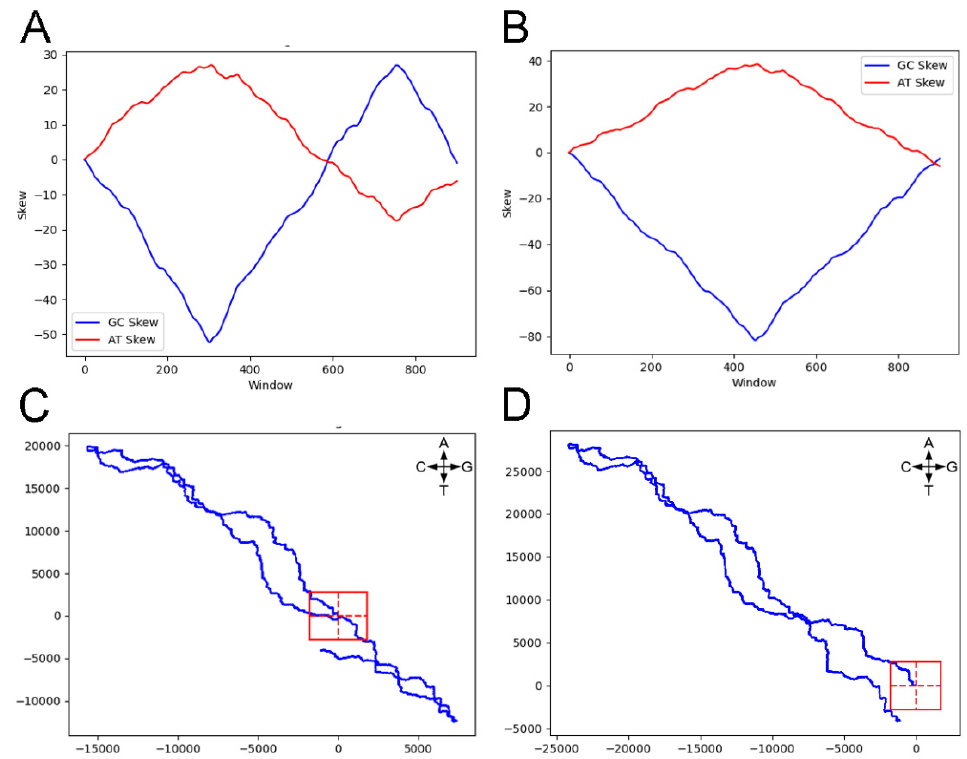
Figure 1. Skew analyses ( A , B ) and genome walks ( C , D ) for B. burgdorferi . The GC skews are shown in blue, while the AT skews are in red. Both use a window size of 10,000 with an overlap of 1000. For the genome walks, the direction of change for each base is indicated; the AT walk is on the vertical axis and the GC walk along the horizontal axis. The origin of the walk is the intersection of the dotted lines and the degree of significant deviation for p = 0.01 (see Equation (1)) is outlined by the red box. The GC walk is along the horizontal. The left two plots ( A , C ) start at a random genome location, while ( B , D ) are “adjusted” to start at the genome location where the AT walk shows maximum deviation from the origin.